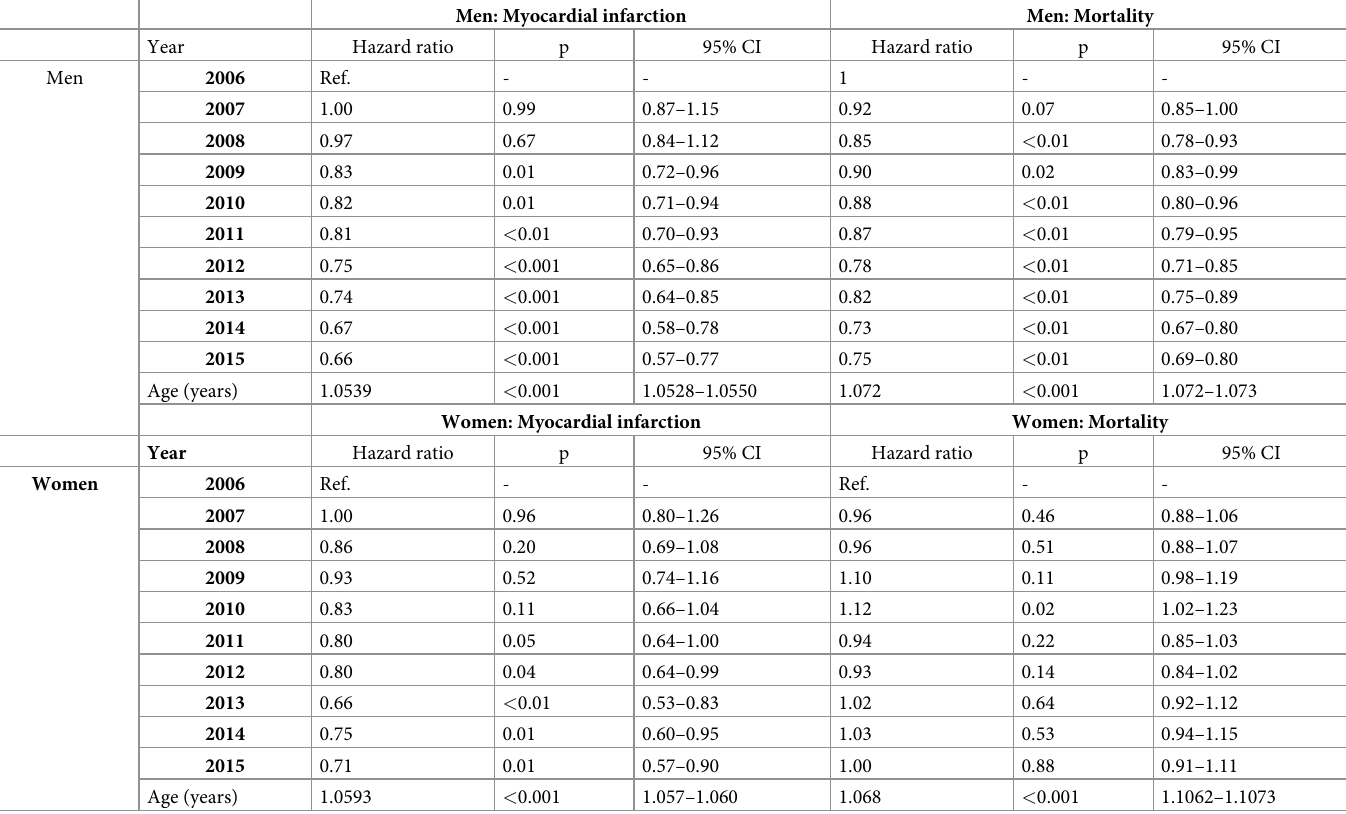
Table 3. Onsets of myocardial infarctions and mortality in women and men by controlling for insurance group: Hazard ratios, standard errors and confidence